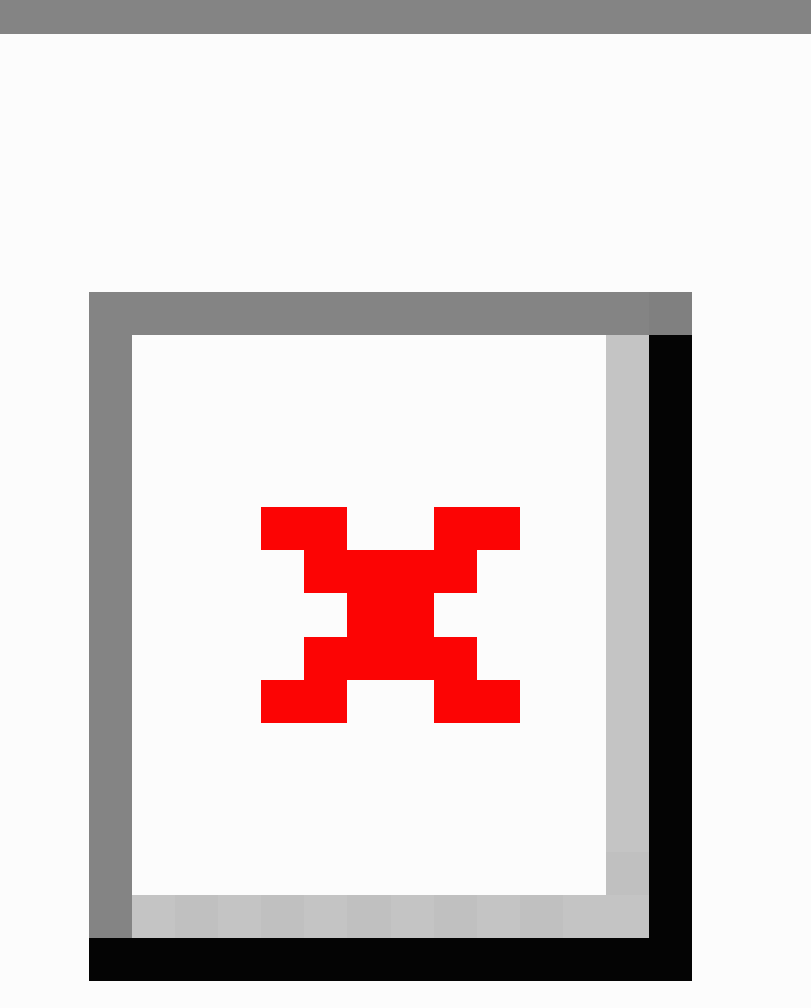
Figure 2. Phase II weight regain (kg) for each website use category shown as 95% confidence interval for the mean (two-tail P value testing for differences based on linear regression analysis adjusted for race, sex, education, income and age, P =